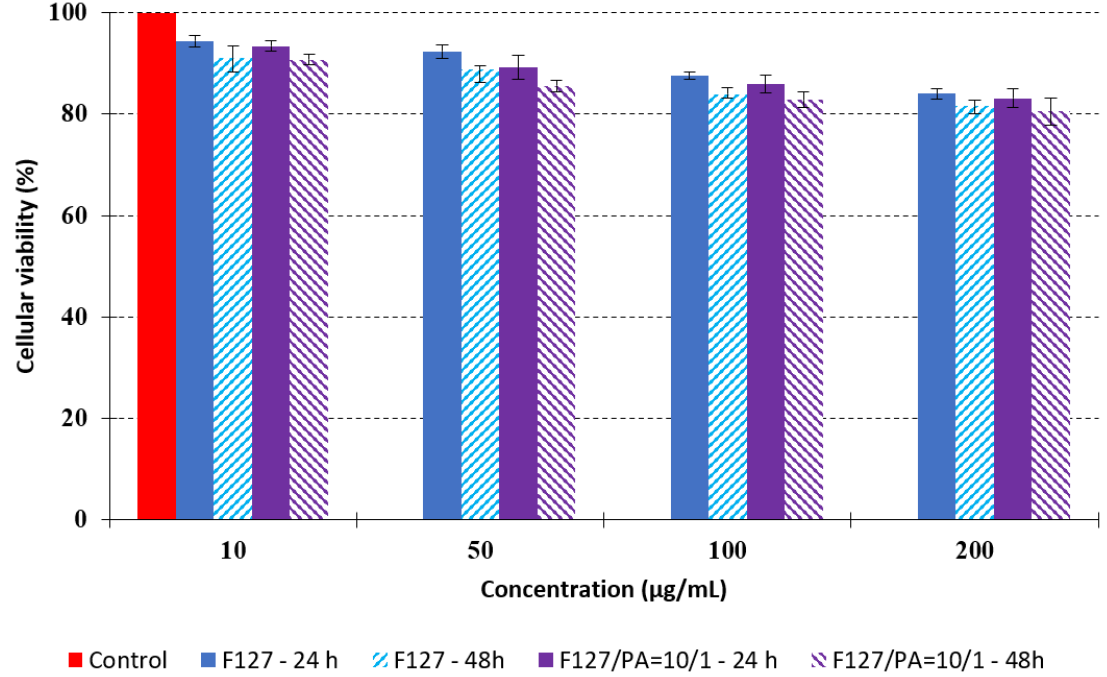
Figure 6. Evolution of the in vitro cellular viability after 24 and 48 h as a function of the concentration for sample F127/API = 10/1.